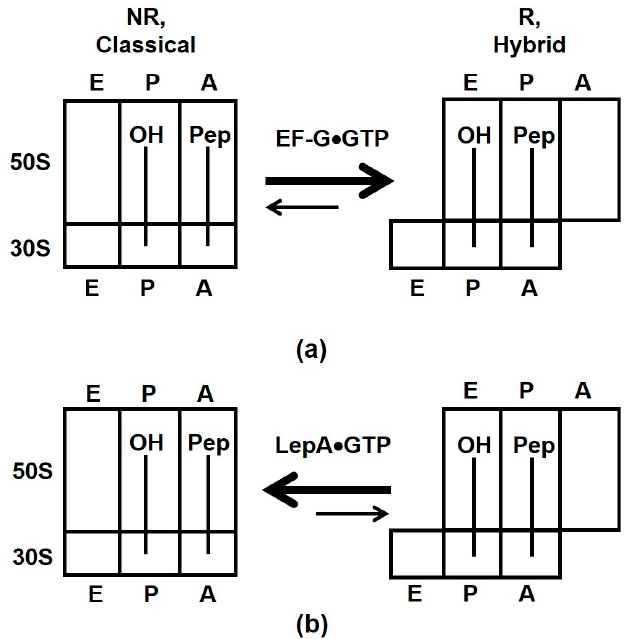
Figure 5. Effects of EF-G ( a ) and LepA ( b ) binding on the equilibrium between the NR, classical and R, hybrid states of the ribosome. Letters E, P and A indicate exit, peptidyl and aminoacyl tRNA binding sites on the 30S and 50S subunits.